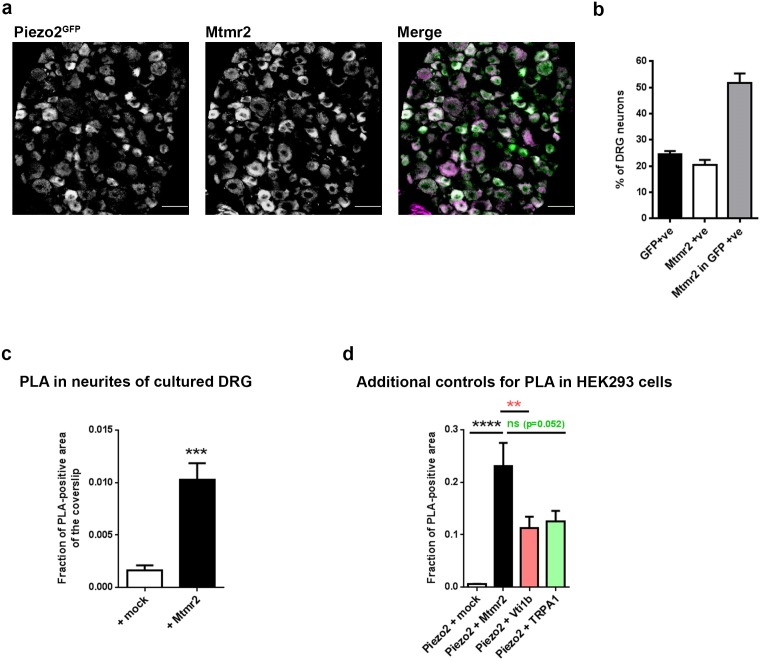
Mtmr2 is expressed in mouse DRG and also in close vicinity to Piezo2.(a) Representative immunohistochemistry and (b) quantification of Mtmr2-positive neurons in cryosections of DRGs obtained from Piezo2GFP mice (Woo et al., 2014). 20.37 ± 2.01% of DRG neurons exhibit positive Mtmr2 immunolabel and 24.53 ± 1.21% of DRG neurons were positive for GFP indicating the presence of Piezo2. Among Piezo2-positive cells, 51.61 ± 3.71% cells were found to be Mtmr2-positive. n > 2000 neurons, N = 3 independent animals. (c) Quantification of the intensity of PLA signal in neurites of cultured DRG neurons (p<0.0001 compared to mock, Mann Whitney test; + mock: n = 94 regions from six coverslips; + Mtmr2-myc: n = 115 regions from six coverslips. (d) Quantification of PLA signal upon co-expression of Piezo2 with mock, Mtmr2, Vti1b (Vesicle transport through interaction with t-SNAREs homolog 1B) or TRPA1 in HEK293 cells. PLA was performed using antibodies against GST and myc to detect Piezo2-GST-IRES-GFP and myc-tagged proteins, respectively. PLA signal (fraction of PLA-positive area) upon co-transfection of mock, Vti1b and TRPA1 served as negative controls and was indeed much smaller than the PLA signal upon co-transfection of Piezo2 and Mtmr2 (p<0.01, in case of TRPA1 p=0.052 compared to Piezo2 + Mtmr2, Kruskal-Wallis test followed by Dunn´s multiple comparison test; Piezo2-GST + mock: n = 60 cells; Piezo2-GST + Mtmr2-myc: n = 35 cells; Piezo2-GST + Vti1b-myc: n = 54 cells; Piezo2-GST + TRPA1-myc: n = 83 cells). Only cells with pronounced GFP signal (due to expression of Piezo2-GST-IRES-GFP) were considered for the analysis. All experiments were performed in parallel.